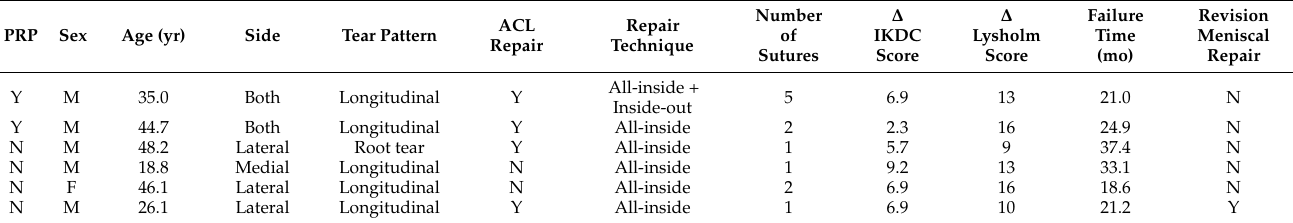
Table 5. Failure case characteristics.